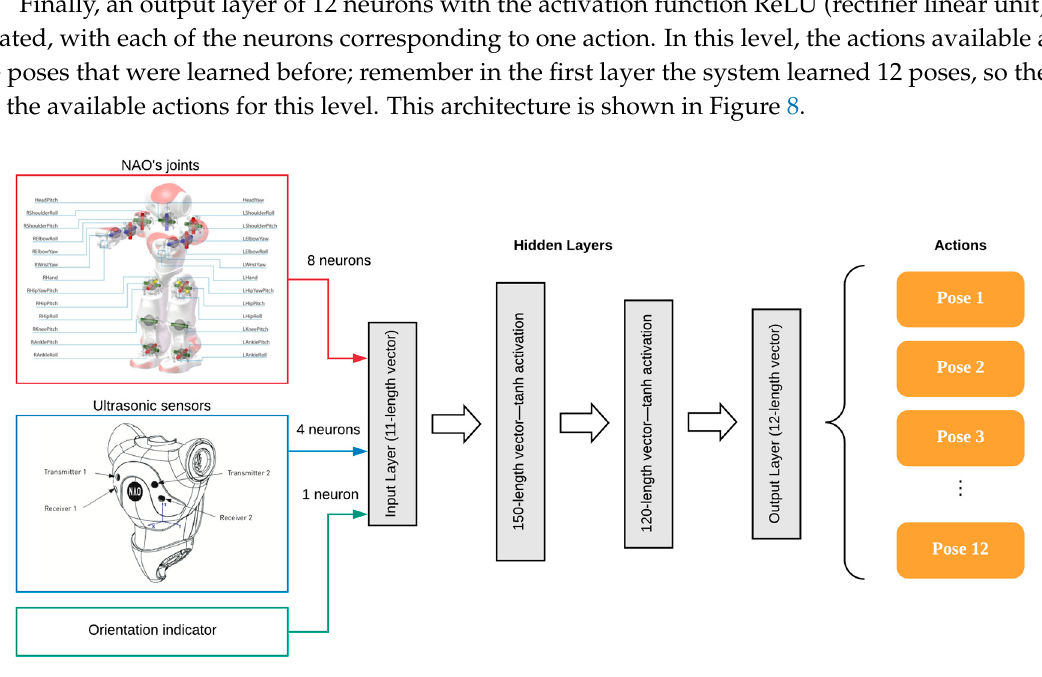
Figure 8. Second Level Q-network.